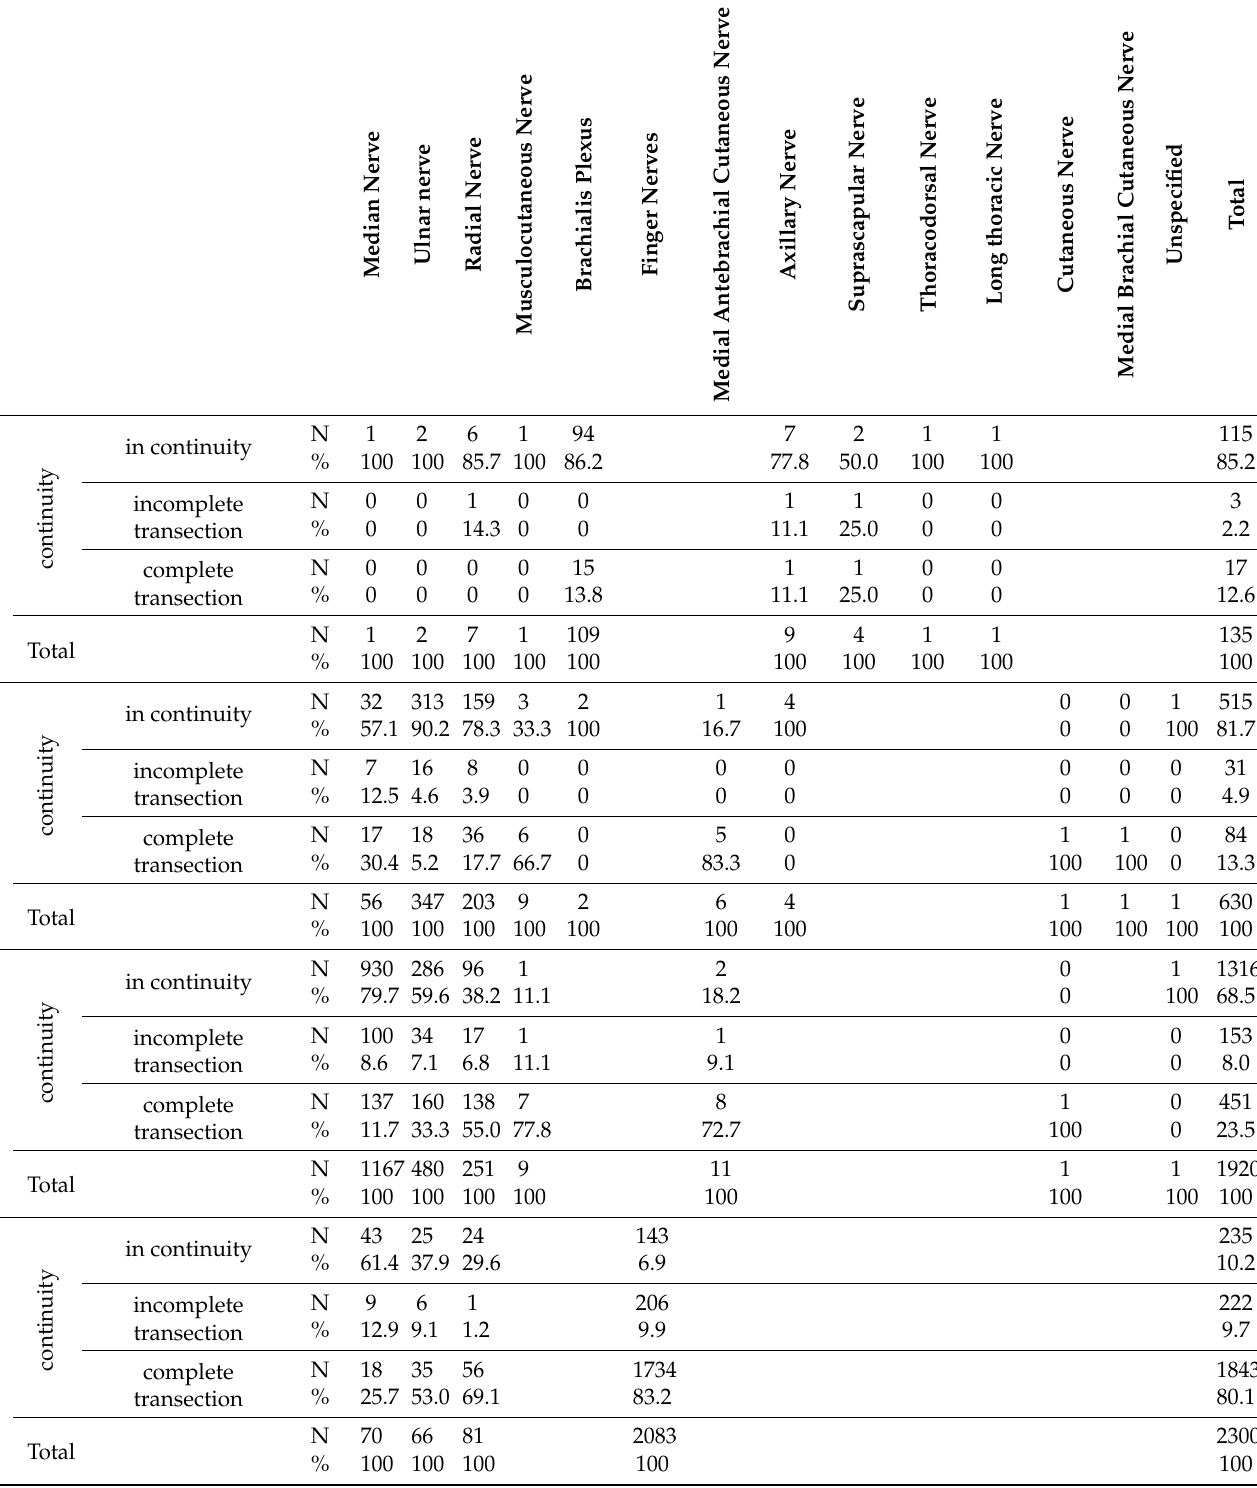
Table 2. Intraoperative findings demonstrate various percentages of nerve continuity according to affected nerve and level. Nerves where no intraoperative records could be obtained are not displayed in the